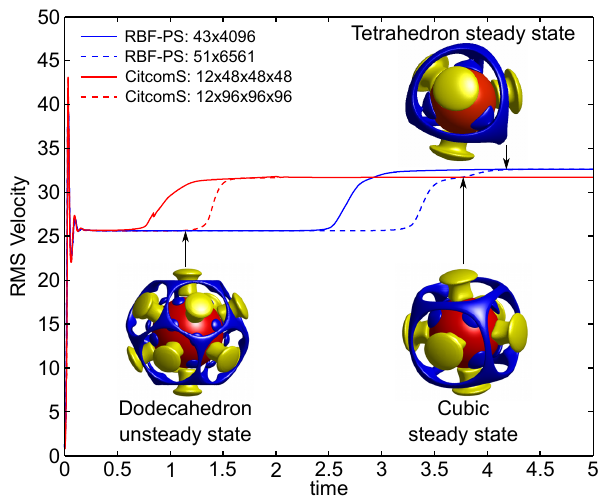
Figure 8. Time trace of the rms velocity for both models at Ra = 7000 for two different spatial